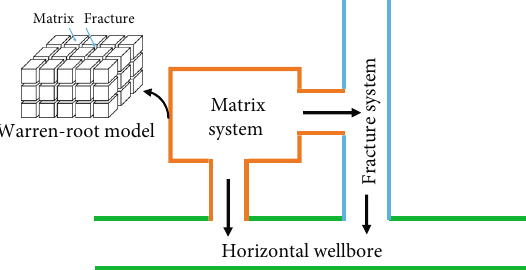
Figure 2: Dual-porosity and dual-permeability fl ow